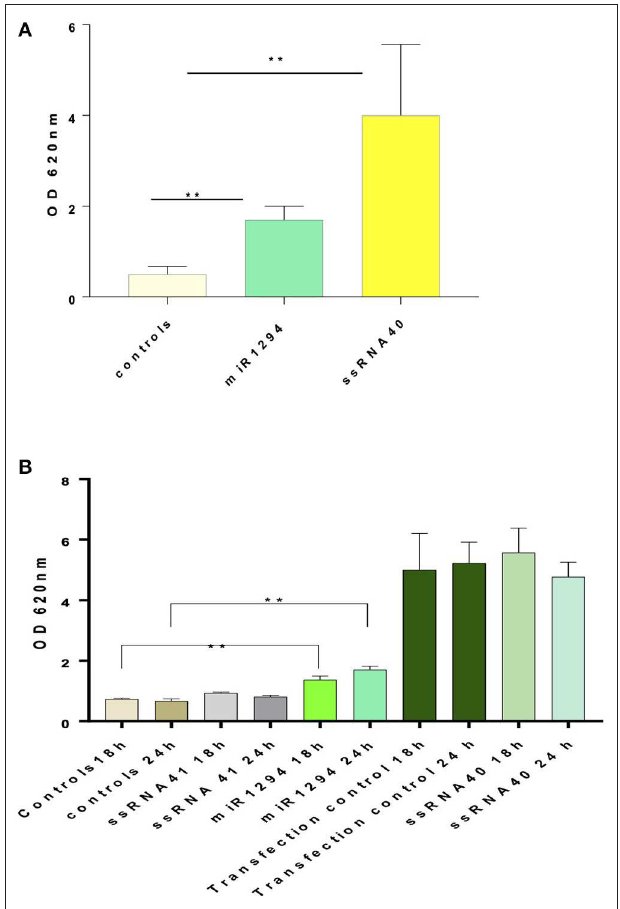
FIGURE 1 | miR-1294 effects NF ´ kB-induced SEAP in TLR-8 expressing cells. (A) HEK-Blue TM hTLR-8 cells (Invivogen, San Diego, CA), a stable commercial cell line co-transfected with hTLR-8 gene and an optimized secreted embryonic alkaline phosphatase (SEAP) reporter gene were incubated with miR-1294 mimic for 24h. (B) HEK-Blue TM hTLR-8 cells (Invivogen, San Diego, CA), were incubated with miR-1294 mimic or controls for 18 or 24h. Negative controls were HEK-Blue TM TLR8 cells alone and HEK-Blue TM hTLR cells incubated with ssRNA4. Positive controls were HEK-Blue TM hTLR8 cells incubated with ssRNA40 were and transfection controls. SEAP levels were quantified by spectrophotometry at 620nm. Bars represent the mean of the three independent experiments with SEM. All experiments were replicated three times. Data analyzed by one-way ANOVA and Dunnet’s post-hoc test. ** p < 0.01; *** p <